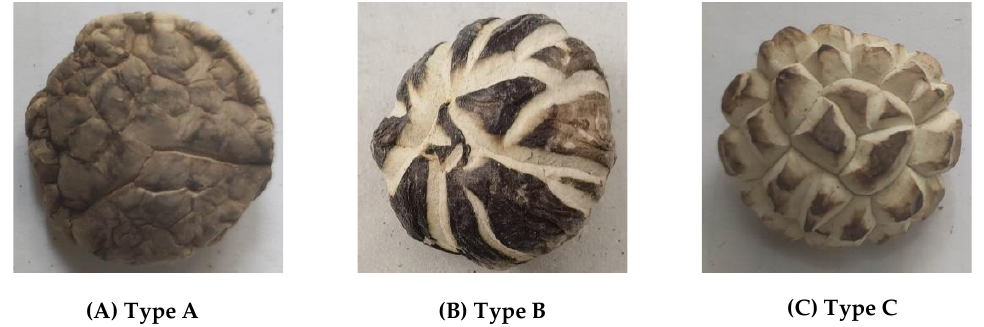
Figure 1. Sorting of shiitake mushrooms according to texture.